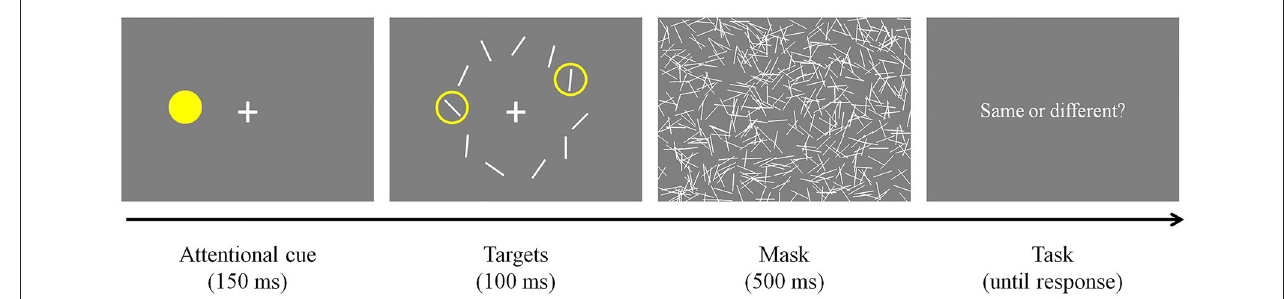
FIGURE 3 | Experimental paradigm. After an attentional cue was presented for 150ms, two target stimuli surrounded by yellow rings and distractors were presented for 100ms. The stimulus array was masked for 500ms to remove sensory memory. Participants responded whether the targets were the same or different by pressing buttons on a keyboard.